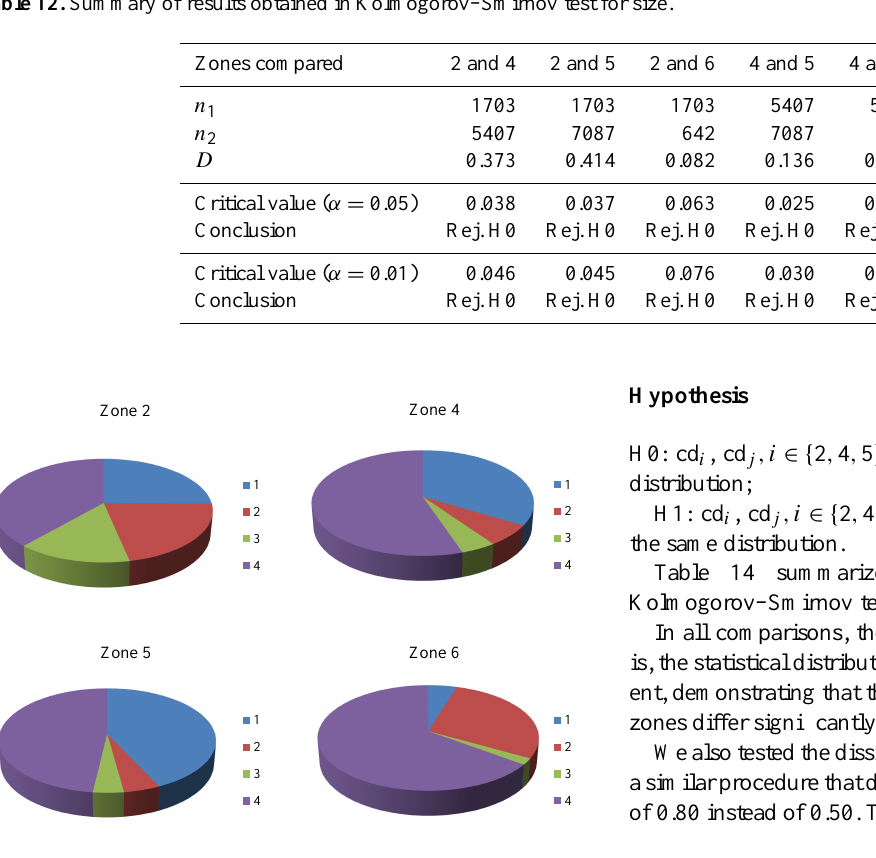
Fig. 11. Graphical representation of cd i ,i ∈ { 2 , 4 , 5 , 6 } .